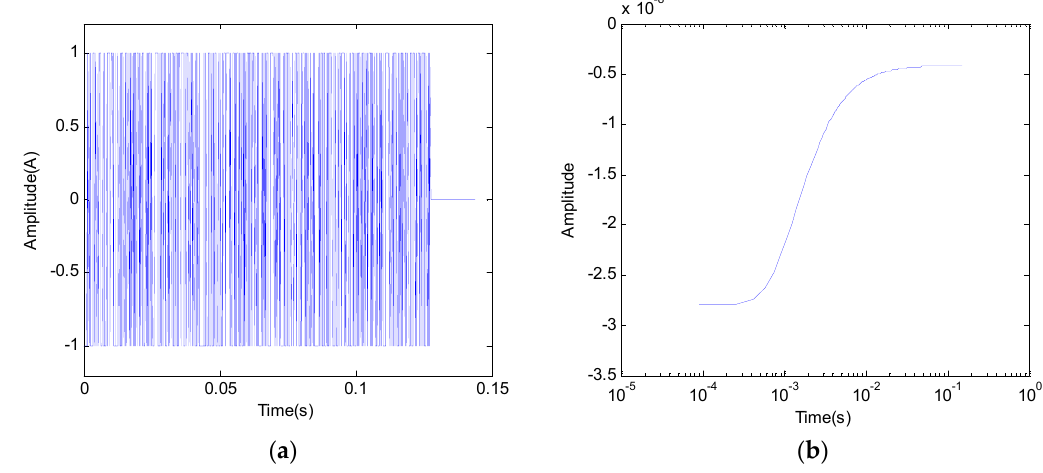
Figure 2. Numerical calculation model. ( a ) Emission waveform; ( b ) uniform half-space step response.